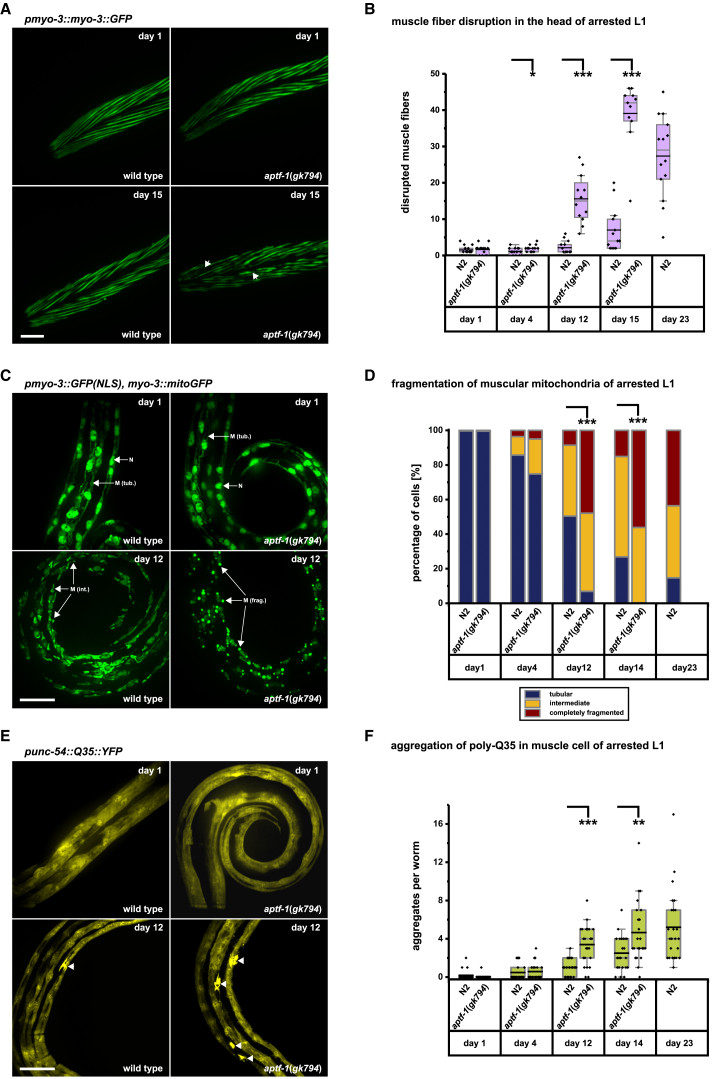
Sleep Counteracts the Progression of Aging Phenotypes during L1 Arrest(A and B) Body-wall muscle myosin deteriorates faster in aptf-1(−). (A) Shown is the head region of transgenic worms expressing GFP-tagged myosin (representative examples). After two days of starvation, muscle structure appears intact in both wild-type and aptf-1(gk794). After fifteen days of starvation, muscle myosin deterioration has progressed much more in aptf-1(gk794) compared to wild-type. Arrowheads point to gaps in muscle structure. (B) Quantification of muscle deterioration. 4 days: n > 10, N2: 1.1 ± 0.3; aptf-1(gk794): 2 ± 0.3, ∗p < 0.05; 12 days: n > 10, N2: 2.2 ± 0.5; aptf-1(gk794): 15.6 ± 1.9, ∗∗∗p < 0.001; 15 days: n > 10, N2: 7 ± 1.7; aptf-1(gk794): 39.1 ± 2.7, ∗∗∗p < 0.001, two-sample t test.(C and D) Mitochondrial fragmentation is increased in aptf-1(−). (C) Mitochondrial morphology appears normal in one day starved larvae, but the initially tubular mitochondria fragmented much faster in aptf-1(−) compared with the wild-type. Mitochondria in body wall muscles were labeled using GFP and were classified as tubular (M [tub.]), intermediately fragmented (M [int.]), or completely fragmented (M. [frag.]). Shown are the mid-body regions of worms, and arrows point to example mitochondrial structures or nucleus (N). (D) For the quantification of mitochondrial deterioration, the percentage of muscle cells displaying each level of fragmentation was determined (12 days—M (frag.): n > 20, N2: 8.5% ± 3.3%; aptf-1(gk794): 47.9% ± 5.9%, ∗∗∗p < 0.001; 14 days—M (frag.): n > 20, N2: 15% ± 3.4%; aptf-1(gk794): 56.1% ± 6.1%, ∗∗∗p < 0.001, two-sample t test).(E and F) Protein aggregation is increased in aptf-1(−). (E) Poly-Q35 was expressed in muscle, and the number of aggregates formed was scored. In one day starved L1, there were almost no detectable aggregates in both wild-type and aptf-1(gk794). Shown are the mid-body regions of worms with arrowheads pointing at aggregates. (F) The number of aggregates increased much faster in aptf-1(gk794) compared with wild-type (12 days: n > 20, N2: 1 ± 0.2; aptf-1(gk794): 3.4 ± 0.4, ∗∗∗p < 0.001; 14 days: n > 20, N2: 2.5 ± 0.4; aptf-1(gk794): 4.7 ± 0.7, ∗∗p < 0.01, two-sample t test).